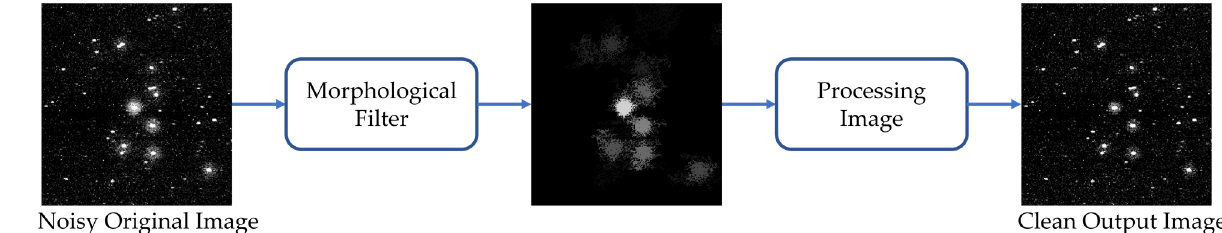
Figure 8. The process of getting a clean image from a real image.